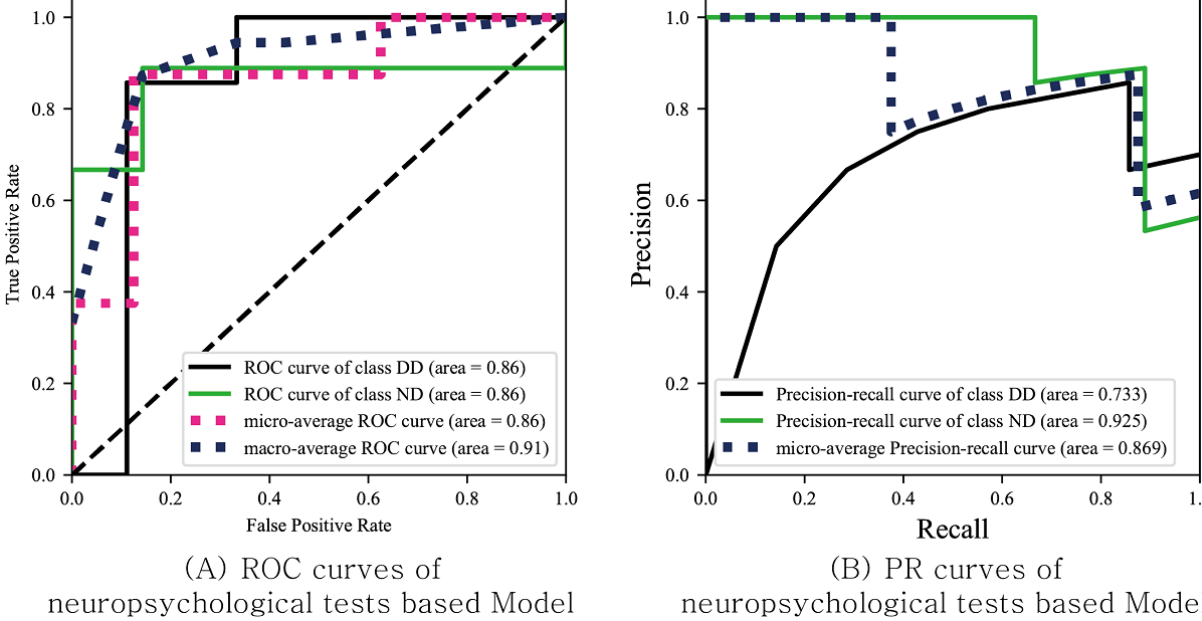
Figure 5. The receiver operating characteristic and precision-recall curves for leave-one-out cross-validation of the model based on the neuropsychological tests. ROC: receiver operating characteristic; DD: developmental disabilities; ND: normal development; PR: precision